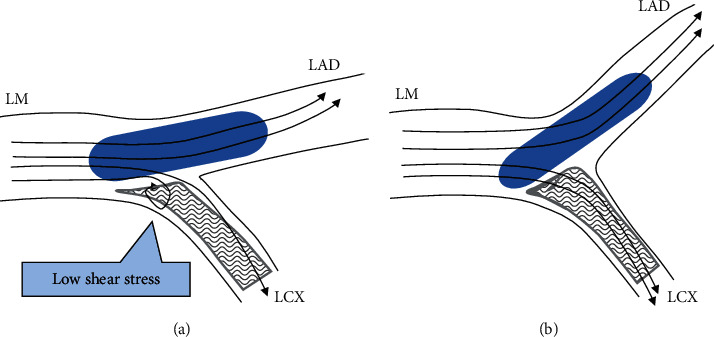
Schematic diagrams of LM bifurcation according to different LM-LAD angles. Blue ovals mean the balloon catheter, gray rectangles mean the stent, and arrows indicate wall shear stress. (a) Wide LM-LAD angle. (b) Narrow LM-LAD angle. LAD, left anterior descending artery; LCX, left circumflex artery; and LM, left main.